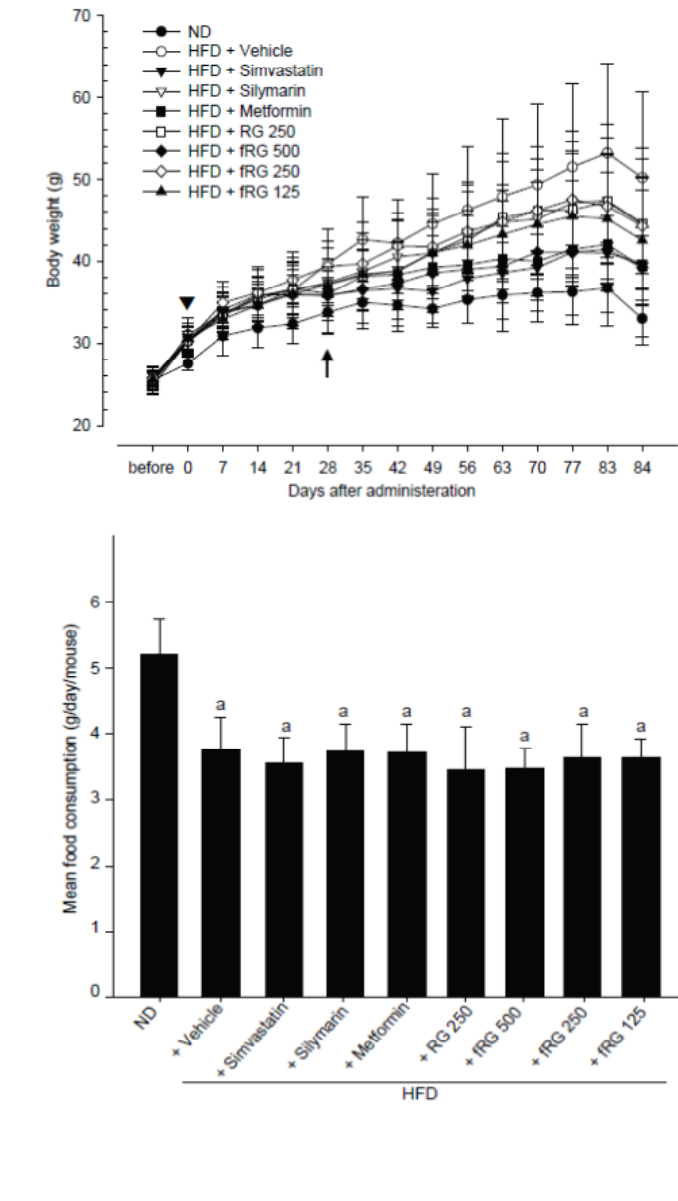
Figure 1. Effect of red-koji fermented red ginseng (fRG) on body weight and food consumption. Mice shown regular body weight increases in HFD-treated groups were selected in adaptation period, and treated HFD with simvastatin (10 mg/kg), silymarin (100 mg/kg), metformin (250 mg/kg), RG (250 mg/kg) or fRG (500, 250 or 125 mg/kg) for 84 days. Body weight changes ( A ) and mean daily food consumption ( B ) during experimental period were calculated as described in material and methods section. All values were expressed mean ± S.D. of eight mice (Significant as compared with normal diet–fed mice, a p < 0.01; ND, normal diet; HFD, high fat diet; RG, red